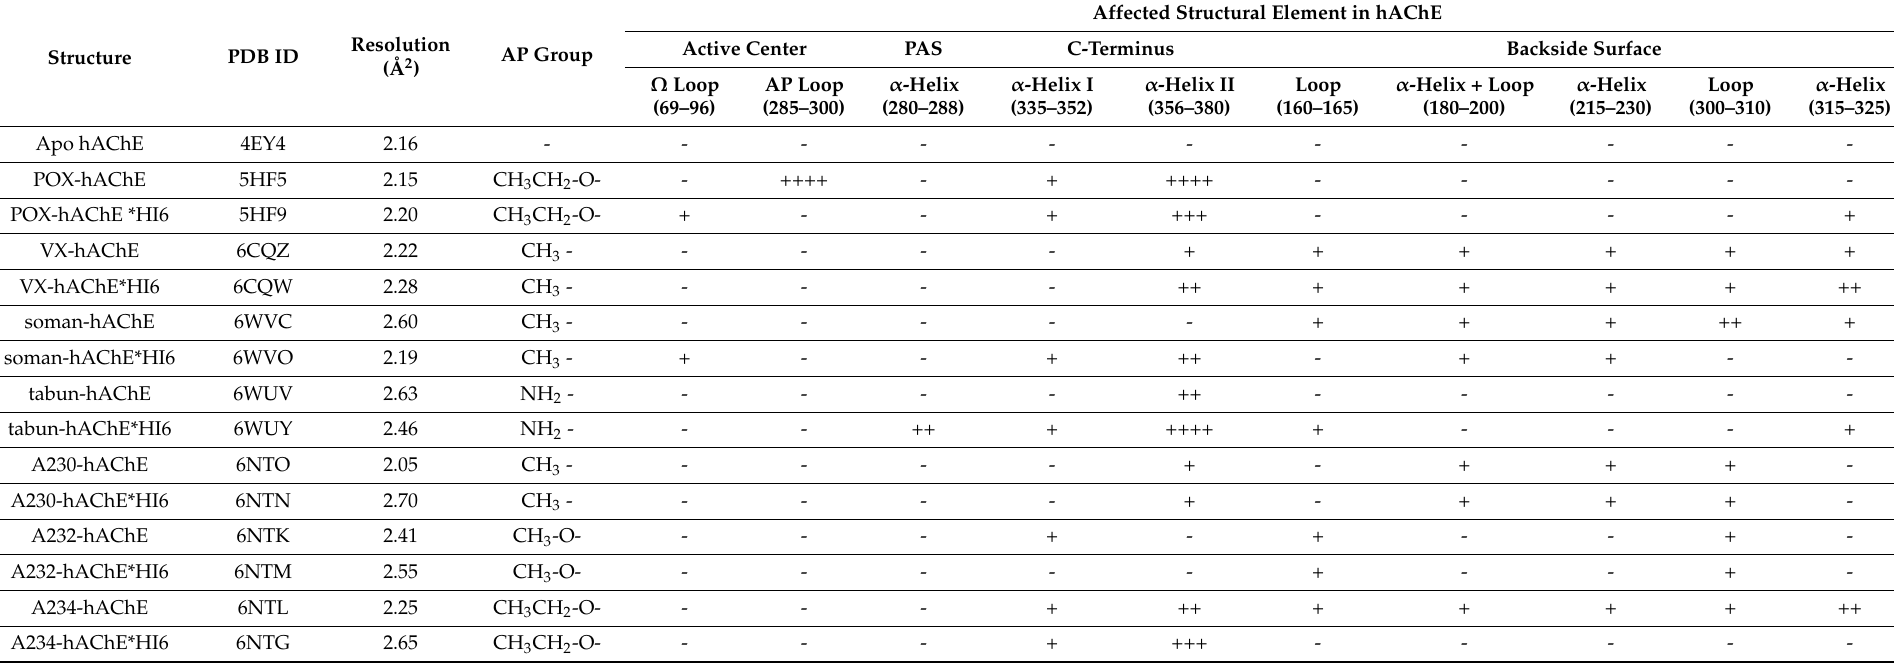
Table 1. Summary of effects of OP conjugation of hAChE and of consecutive, reversible HI6 binding, as evaluated by PACCT 3 from pairwise comparisons of listed X-ray structures with Apo-hAChE (4EY4). Identities of the acyl pocket (AP) stabilized substituents (AP group) on phosphorus atoms for each OP conjugate are given as observed from corresponding X-ray structures. Listed in the table are magnitudes of C α shifts identified in Figures 4 and 6 as significant, from weak (+) to very significant (++++). Locations of ten identified elements in